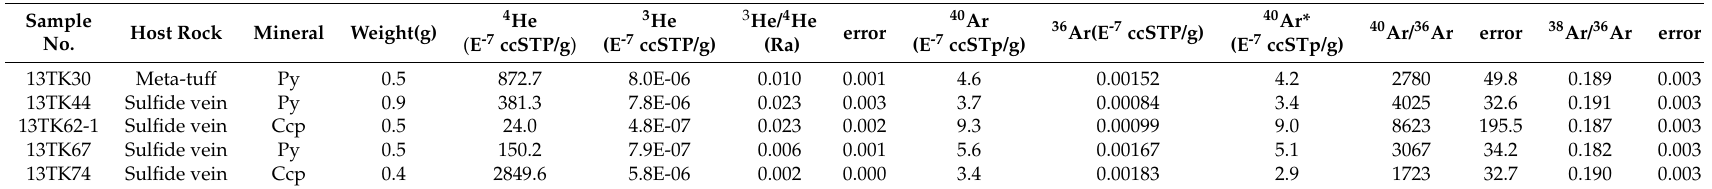
Table 4. Helium and argon isotopic compositions of sulfides of the Tongkuangyu Cu deposit, North China Craton. 40 Ar*: Excess 40 Ar content that is corrected for atmospheric argon Sample